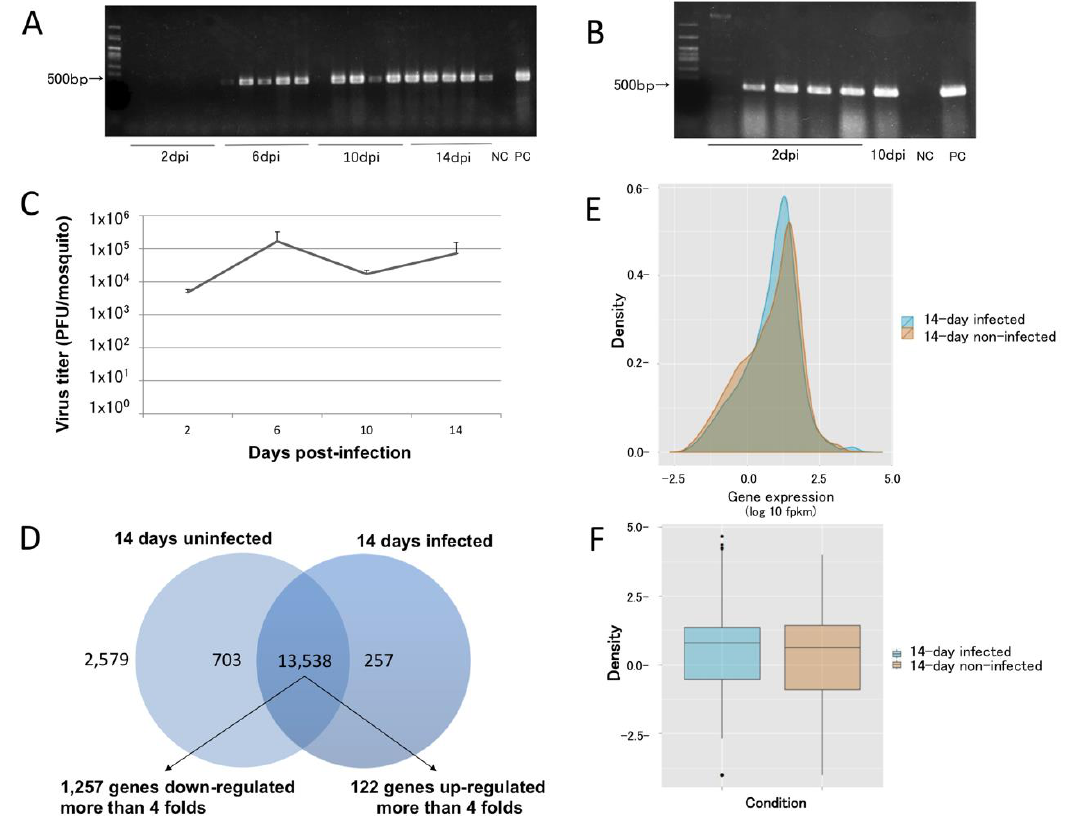
Figure 1. Temporal, spatial, and quantitative dynamics of dengue virus dissemination in Aedes aegypti . ( A ) Dengue virus (DENV) dissemination at 2, 6, 8, and 10 days post-infection (dpi) (N = 5 for each time point). ( B ) At 2 dpi, infected mosquitoes had DENV in their carcasses. One mosquito was not infected, and one 10 dpi mosquito had an apparent midgut escape barrier that prevented DENV dissemination. ( C ) The DENV titer in infected mosquitoes was stable for up to 14 dpi (N = 3). ( D ) As many as 13,538 genes were a ff ected by DENV infection at 14 dpi, with 1257 and 122 genes showing decreased and increased transcript abundance, respectively, by more than 4-fold. As many as 2579 genes had products that showed no di ff erential abundance. ( E , F ) Density and box plots of the overlapped transcript accumulation between 14-day-infected and uninfected mosquitoes. NC: negative control; PC: positive control.